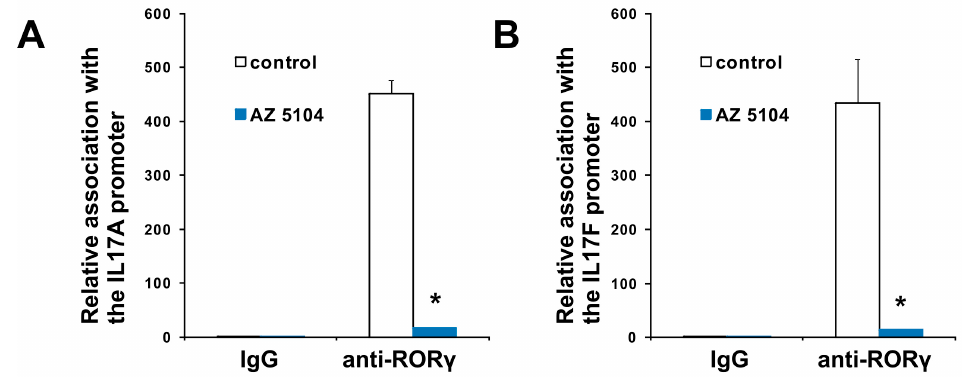
Figure 7. Results of chromatin immunoprecipitation showing that AZ5104 lowers ROR γ T occupancy at the IL17A ( A ) and IL17F ( B ) promoters. Data are presented as mean ± SD, n = 3 (from three different donors), * p < 0.05 compared with control cells.